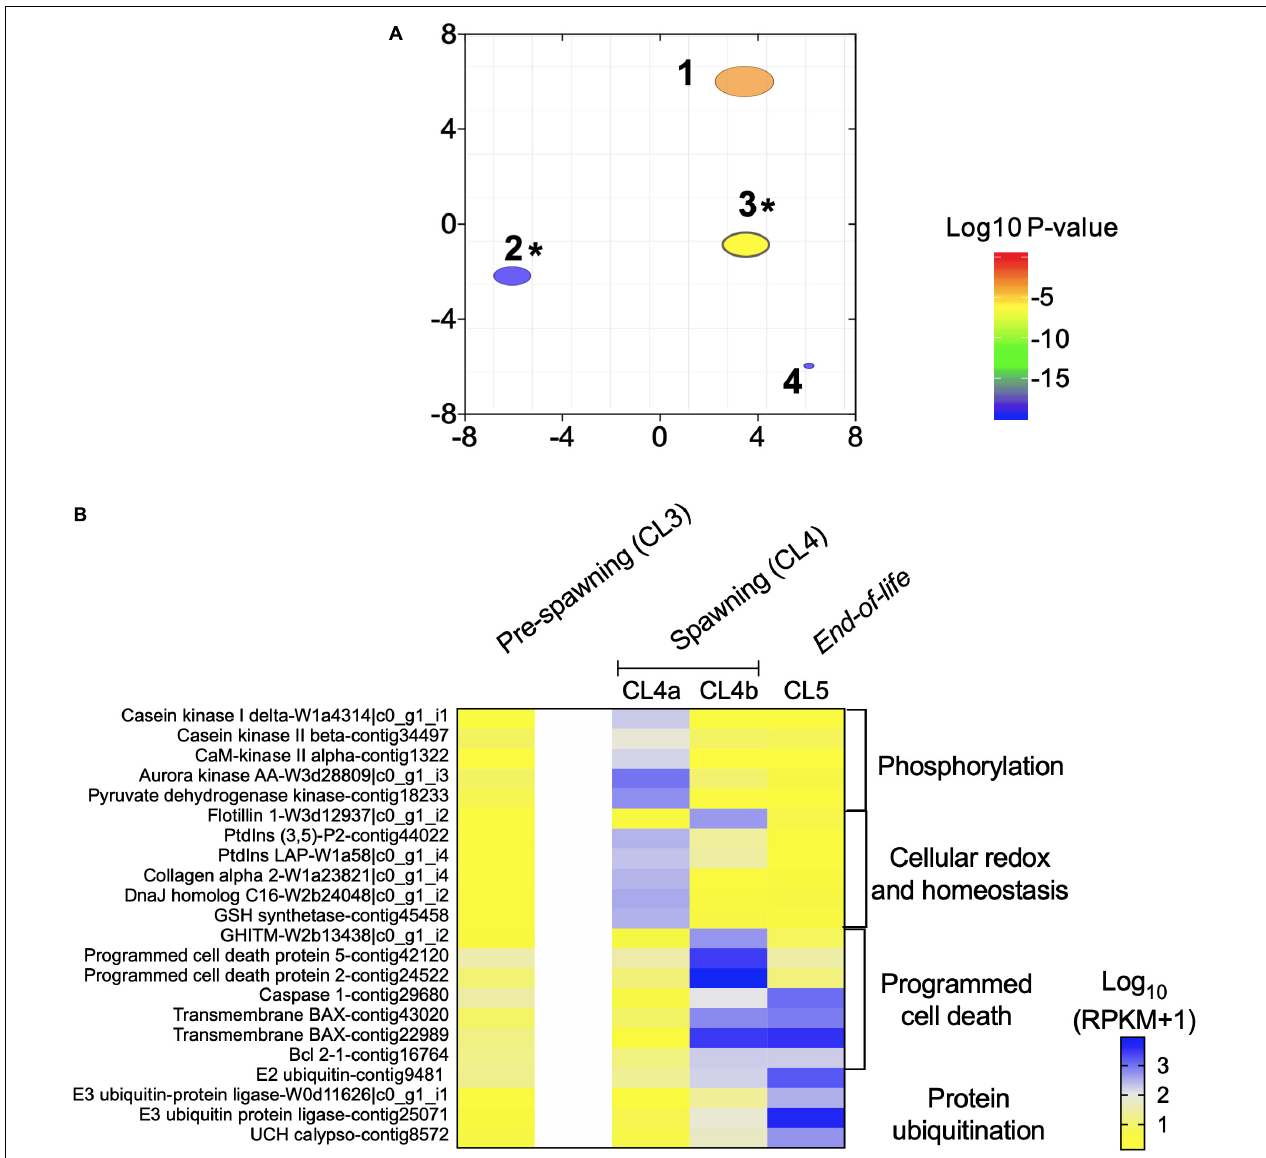
FIGURE 5 | “End of life transition” in Neocalanus flemingeri . (A) ReviGO semantic analysis of the enriched GO terms represented among the DEGs identified in the “end of life” transition by generalized linear model followed by pairwise likelihood ratio tests. Annotations: 1 “phosphorylation” [GO:0016310], 2 “positive regulation of programmed cell death” [GO:0043068], 3 “protein ubiquitination” [GO:0016567], 4 “phosphate-containing compound metabolic process” [GO:0006796]. *Marks GO terms that were also enriched in the previous comparisons ( Figure 2C ). (B) Heat map of relative expression of target genes associated with end of life involved in the processes: “phosphorylation” [GO:0016310], “cellular homeostasis” [GO:0045454], “programmed cell death” [GO:0043068] and “protein ubiquitination” [GO:0016567]. Color-coding for each gene indicates the magnitude of expression as Log 10 (RPKM + 1). Columns are ordered by clusters following the grouping in Figure 1 as indicated by the labels (top). Genes were ordered by functional category (right).